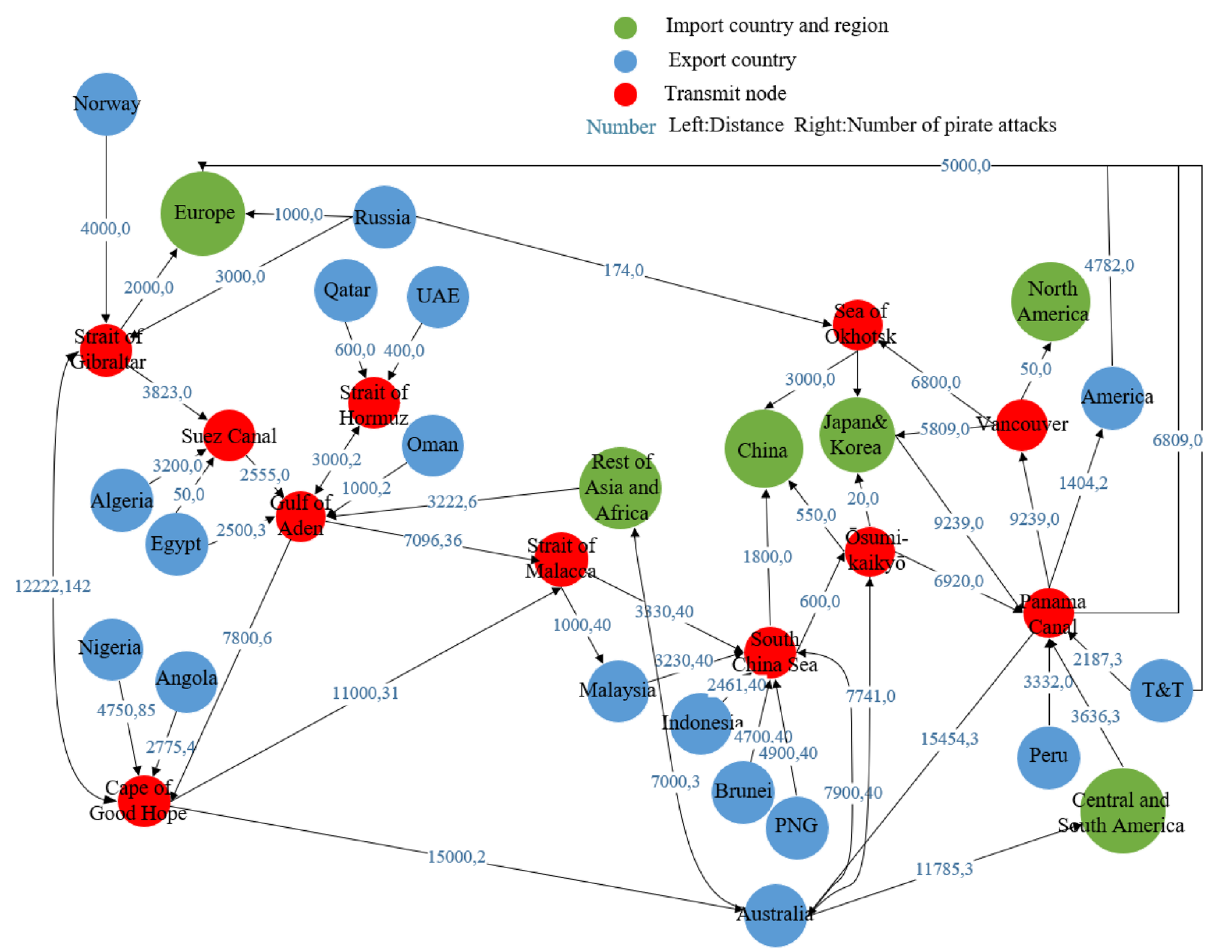
Figure 1. Generalized map of global LNG trade shipping routes (The unit of distance is a